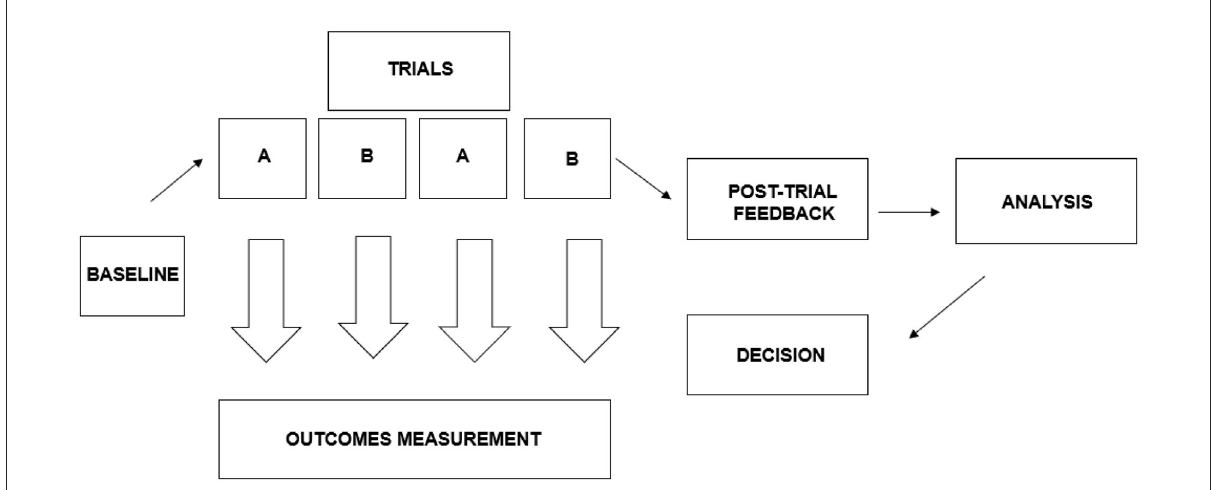
FIGURE1 The N-of-1 trial design used in comparing responses to two interventions. Adapted from Zucker et al.